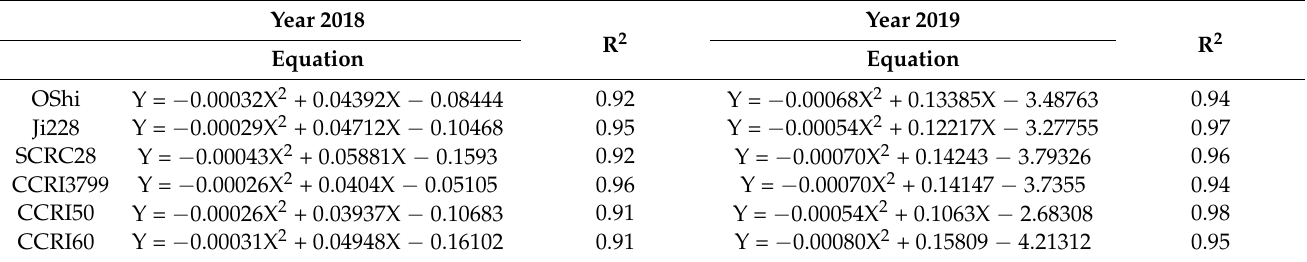
Table 3. LAI simulation equations for six cultivars in 2018 and 2019: Y = aX 2 + bX + c. Year 2018 R 2